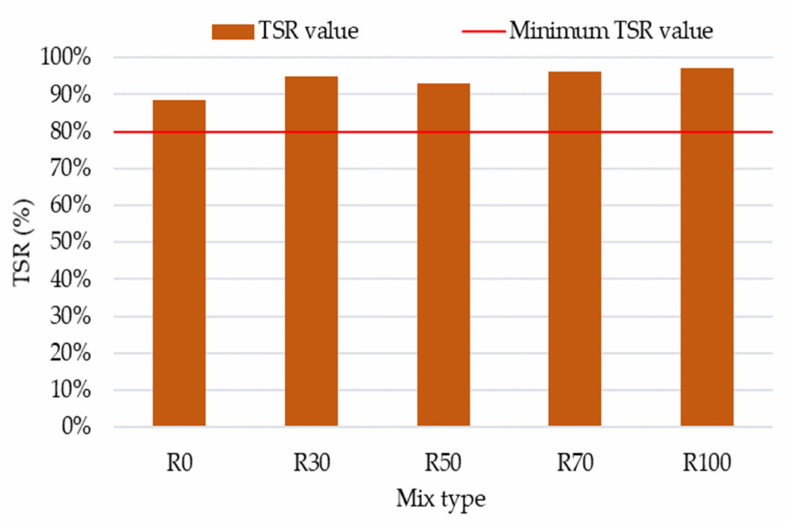
Figure 4. TSR values for the five mixes.